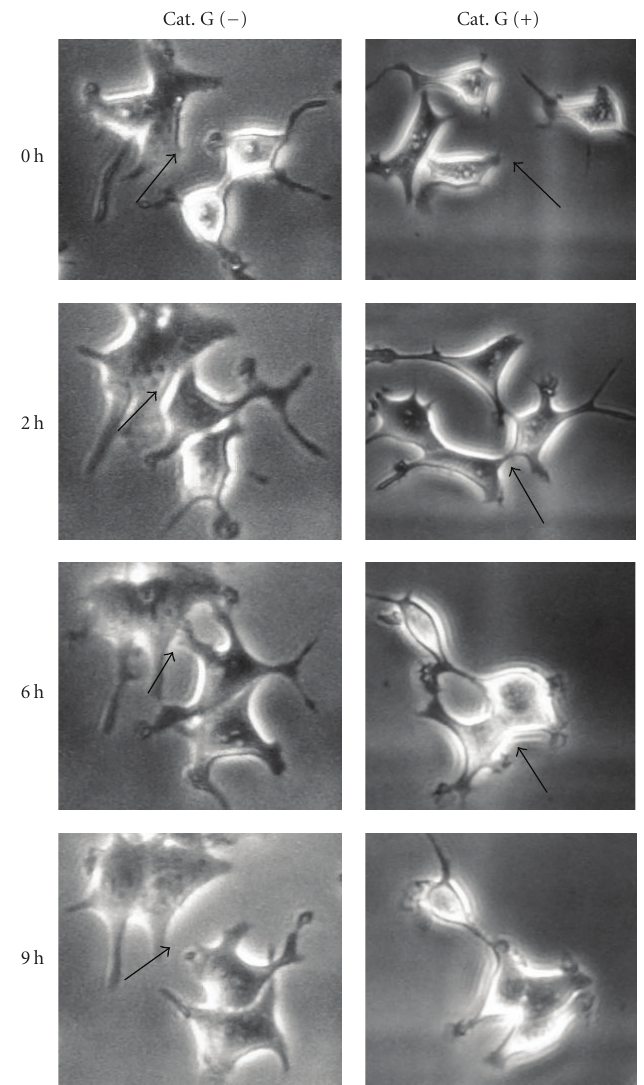
Figure 1: Cathepsin G induces contact inhibition of cell movement. 5 × 10 4 MCF-7 cells were cultured in dishes coated with fibronectin for 24 hours. After washing, adherent cells were incubated in serum-free medium without or with 0.5 mU/mL cathepsin G. Cathepsin G- treated MCF-7 cells were analyzed by phase-contrast microscopy at the same locations in the indicated periods. Cathepsin G-induced contact inhibition of cell movement was observed at the original magnification: × 200. Arrows indicate adhesion sites between